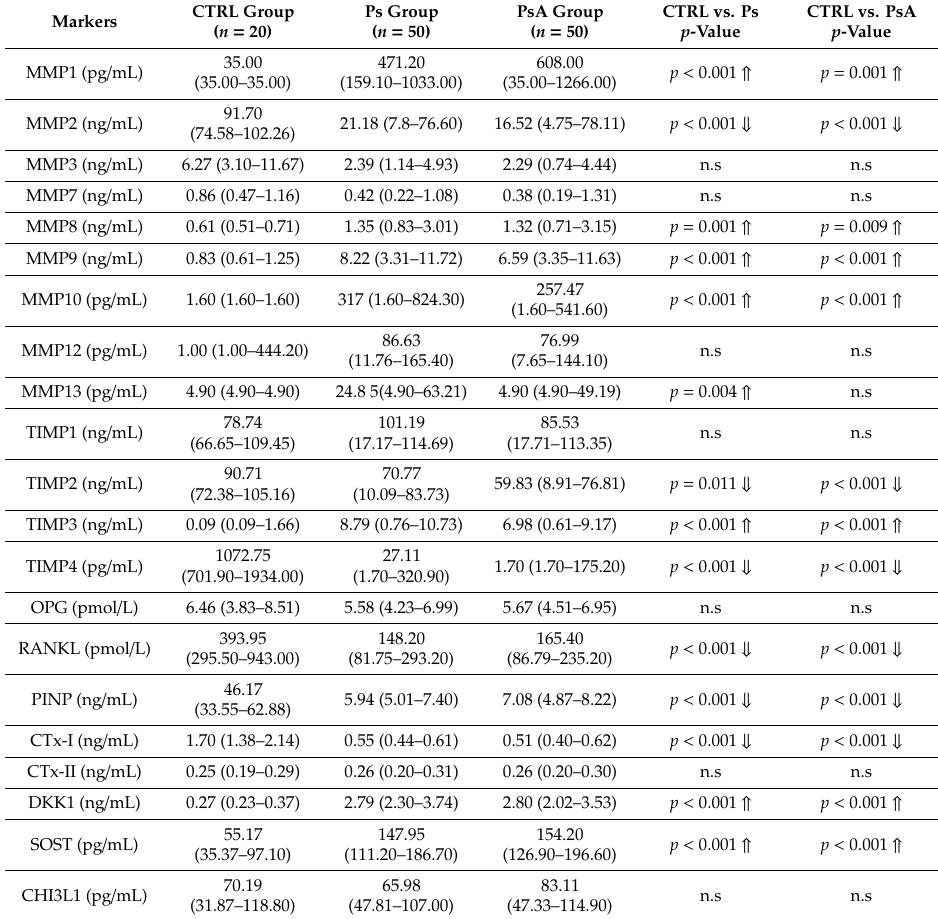
Table 2. Concentration of serum osteoimmunological markers measured in the study